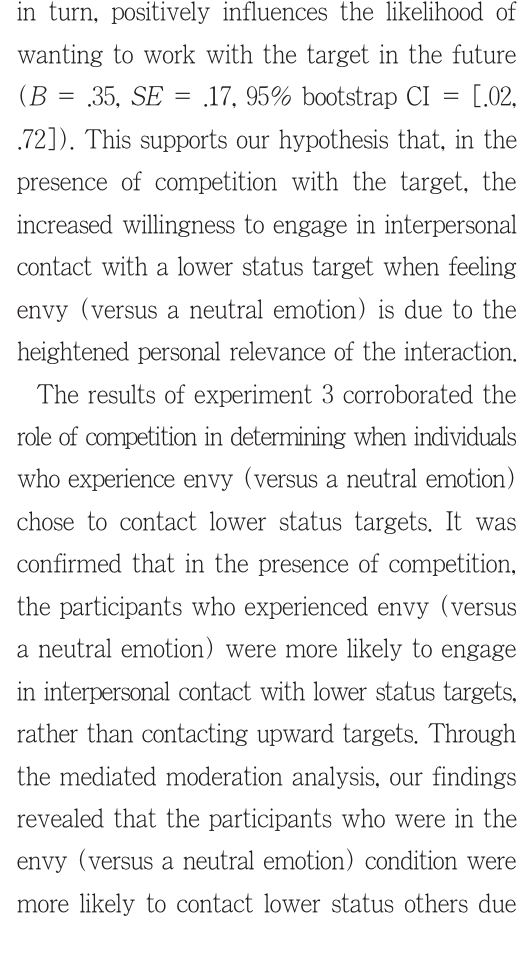
<Figure 4> Conceptual framework for mediated